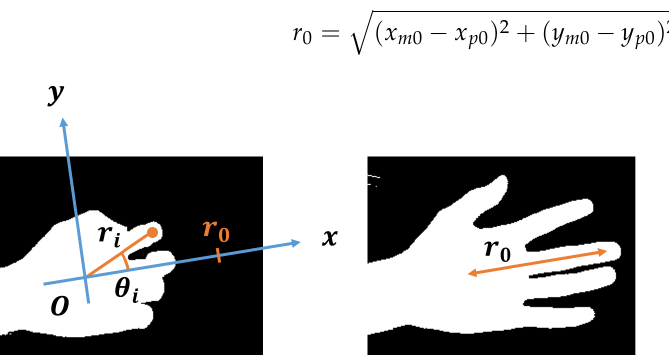
Figure 7. Direction of middle finger and angle between each finger and middle